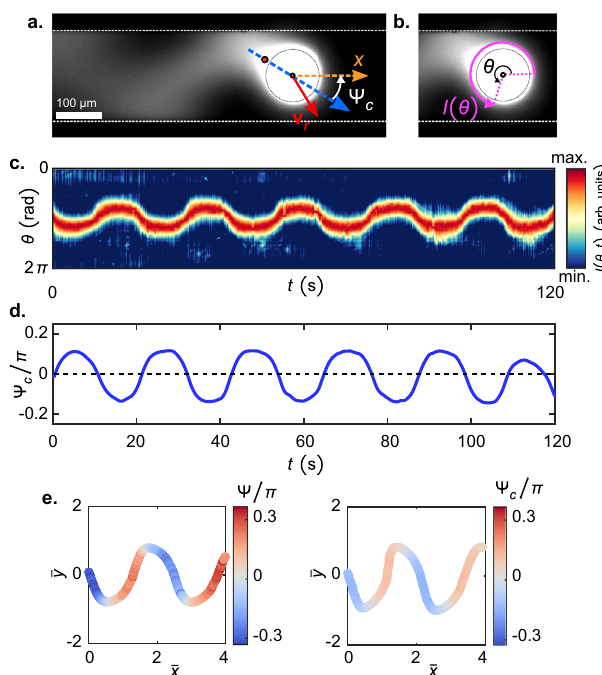
Fig. 4 Characteristics of the chemical ( fi lled micelle) trail of the active droplet during oscillatory rheotaxis. a A fl uorescence microscopy image showing the fi lled micelle trail of the active droplet during the oscillatory rheotaxis. The trail is visualised by doping the droplet with Nile red dye, which co-moves with the oil into fi lled micelles. b De fi nition of the polar angle θ , taken counter-clockwise from ^ x , and the intensity pro fi le I ( θ ) around droplet interface. c Kymograph of I ( θ ). d Temporal variation of the `chemical angle' Ψ c which is supplementary to the angle θ ( I max . ) of maximum I (see (a)). e Comparison between the intrinsic orientation of the active droplet, Ψ , and Ψ c over the oscillatory rheotactic trajectory for (cid:2) u a (cid:1) 0 : 42. The chemical trail is closely aligned with the swimming f orientation, and is not signi fi cantly distorted by the resulting fl ow fi